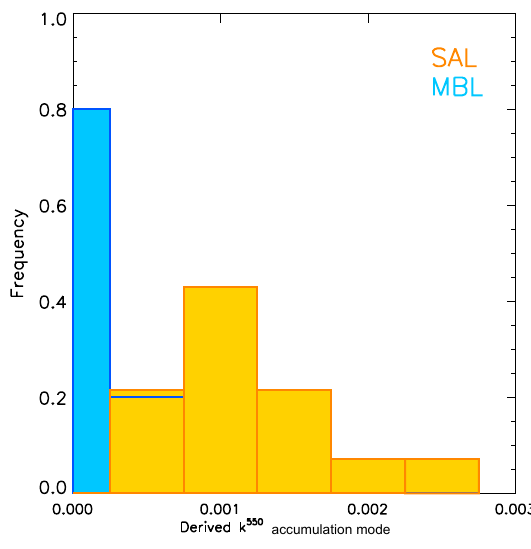
Figure 3. Histogram of derived imaginary part of the refractive in- dex at 550nm ( k 550 ) from iterations for the accumulation mode, shown separately for SLRs in the SAL and